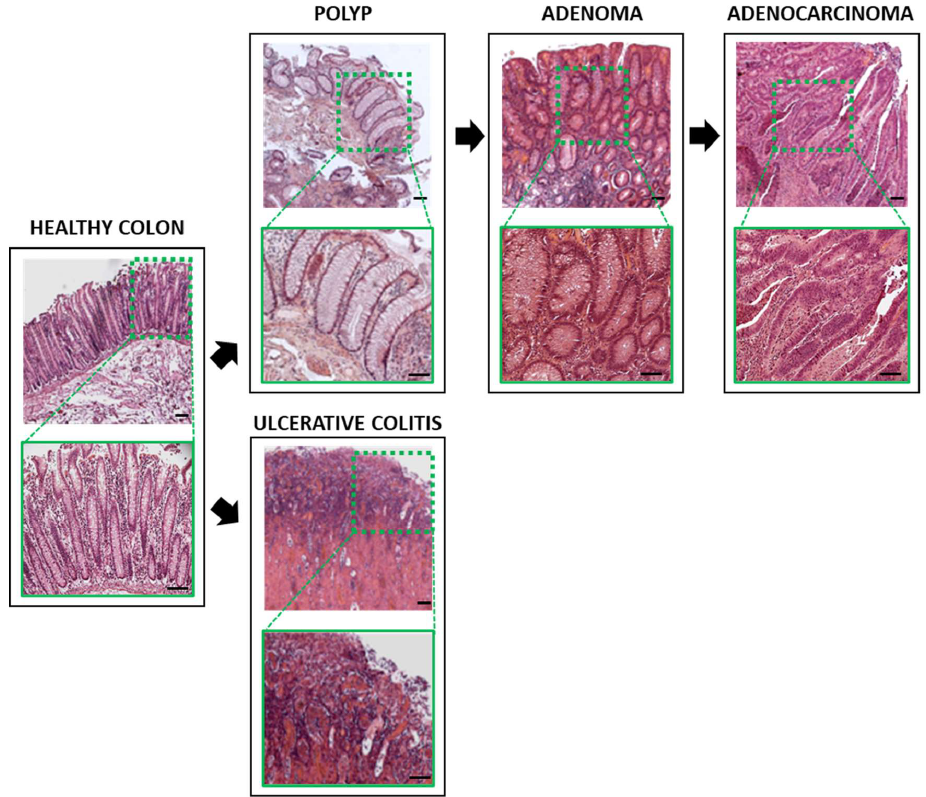
Figure 3. Representative photographs of healthy and pathological human colons. Eosin–hematoxylin-stained, embedded paraffin sections (5–10 µm) of healthy colon, ulcerative colitis, polyps, adenomas and adenocarcinomas are shown. The number of subjects used for each condition was eight. Scale bars represent 100 µm.